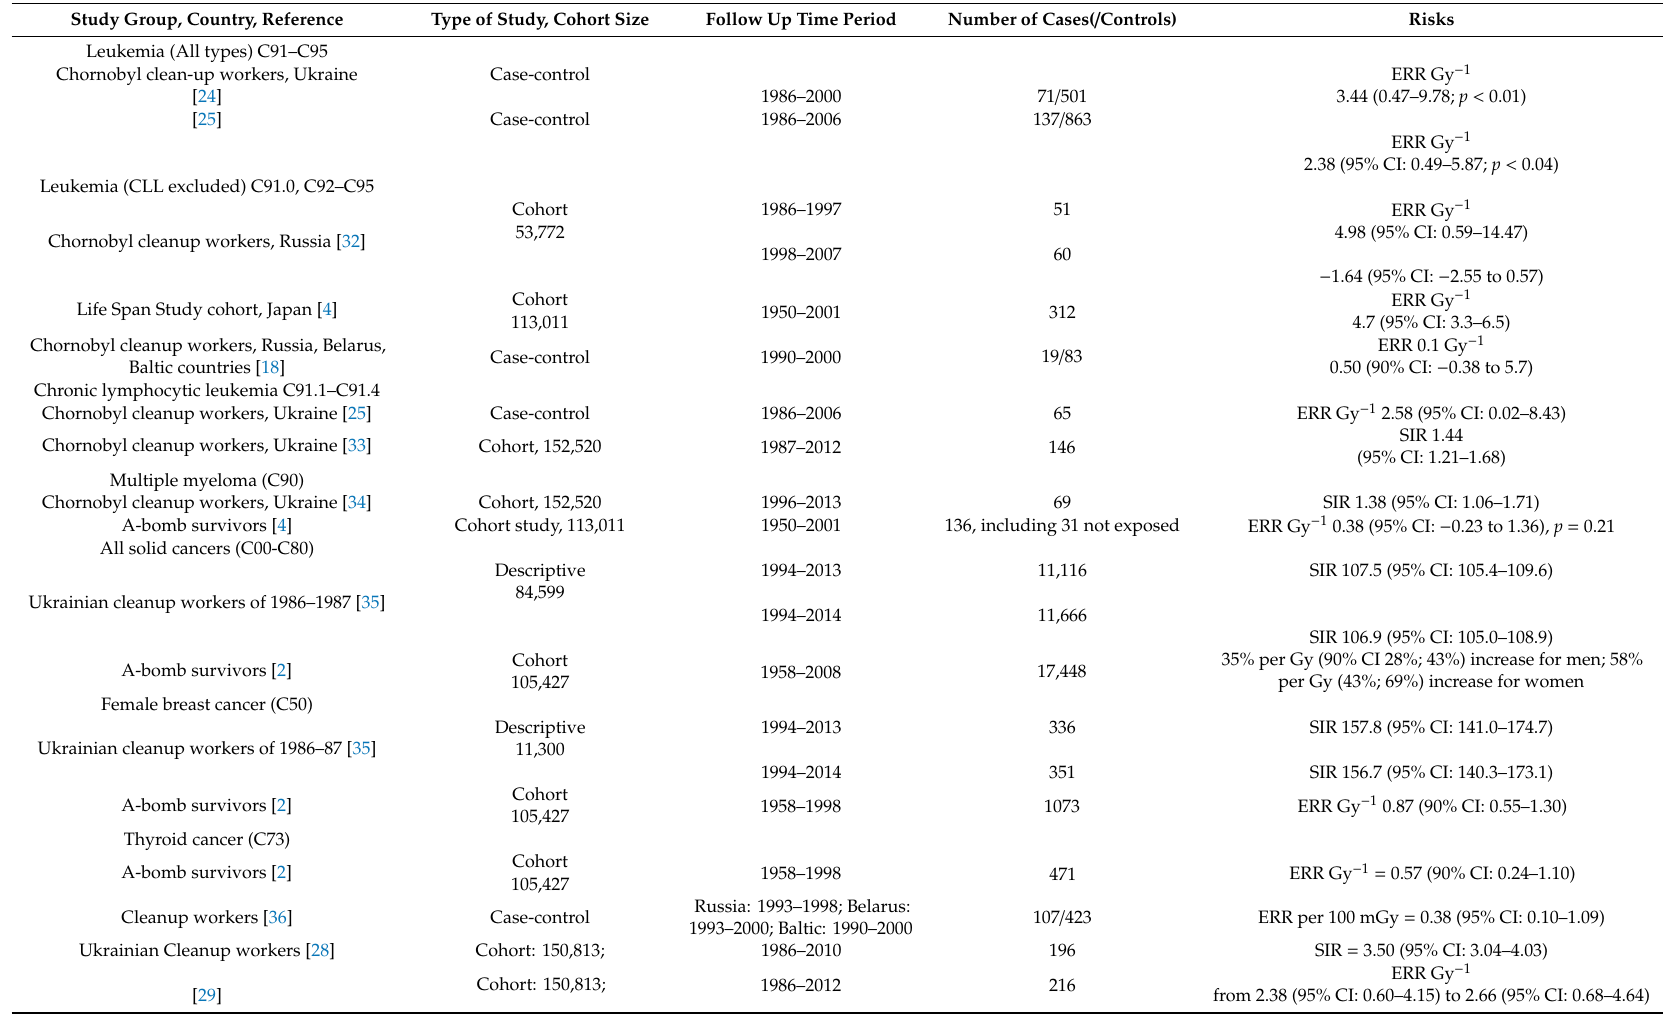
Table 3. Cancer risks in Ukrainian Chornobyl cleanup workers in comparison with other